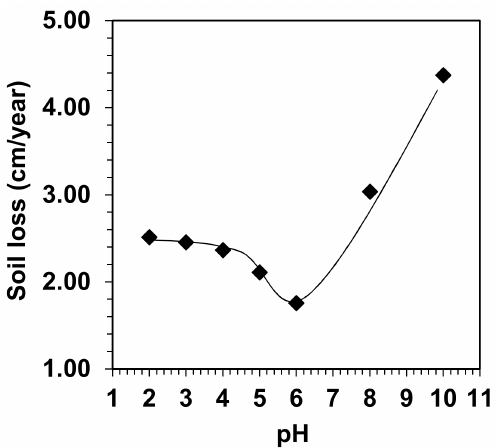
Figure 8. Annual rate of soil water erosion at different pH values ranging from 2.0 to 10.0.